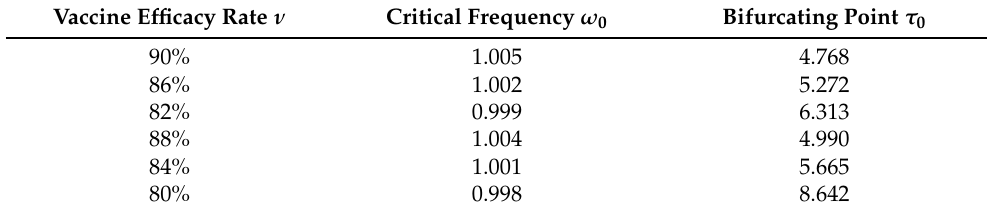
Table 5. Vaccine efficacy rate ν and bifurcating point τ 0